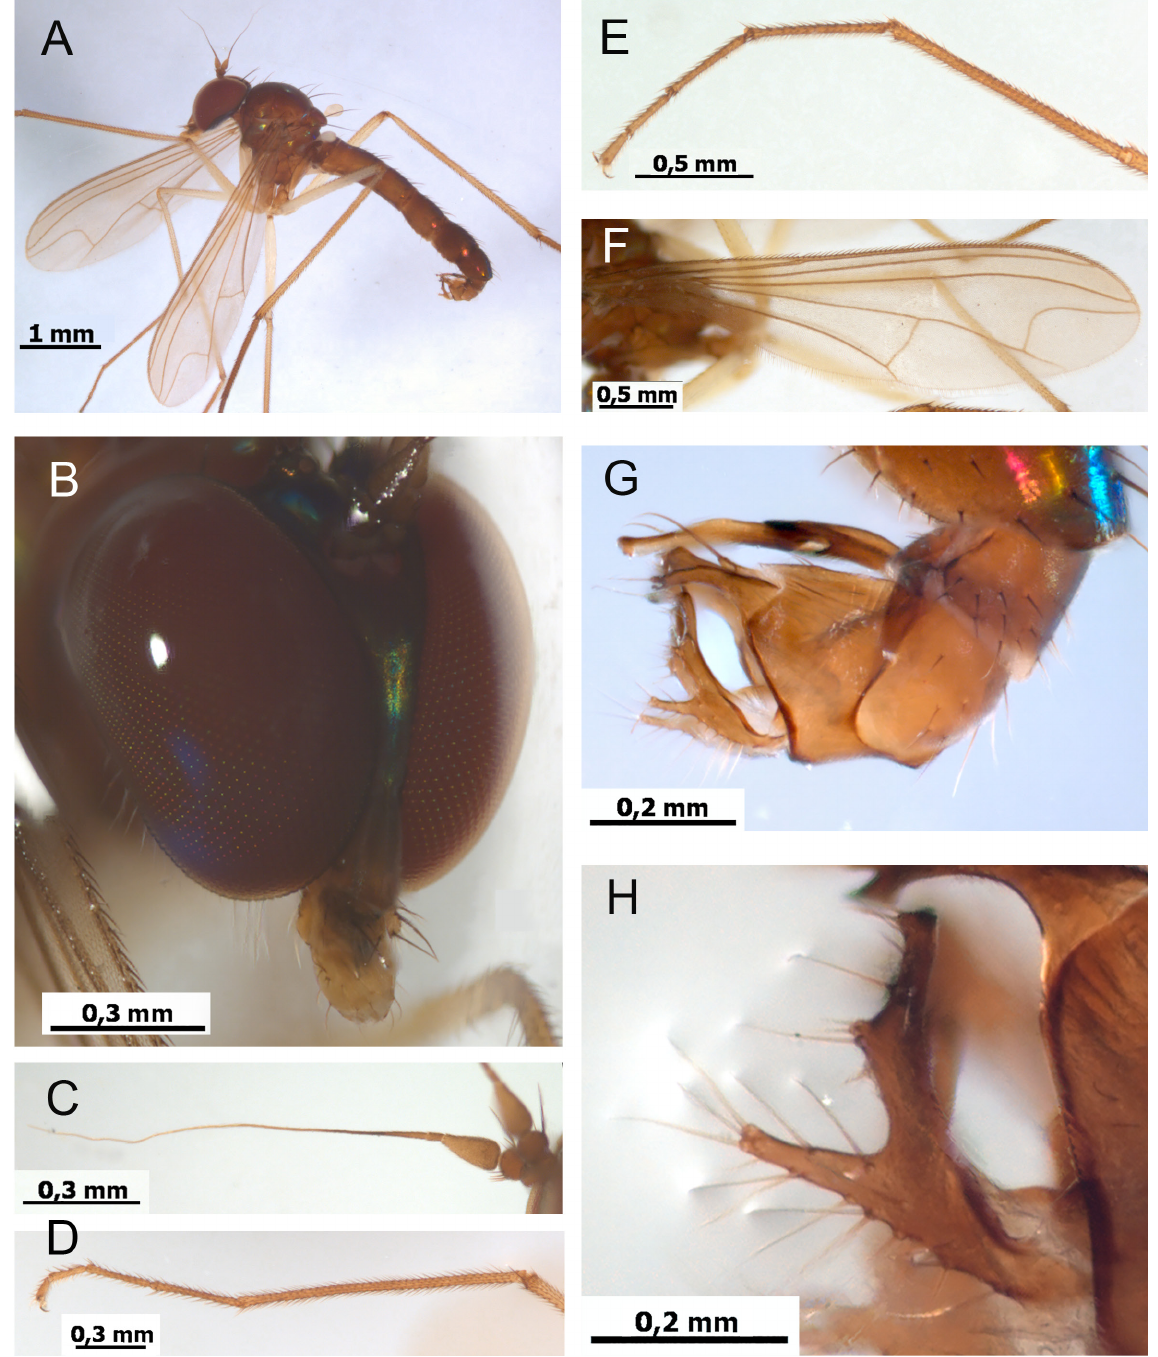
Fig. 7. Amblypsilopus udzungwensis sp. nov., holotype, ♂ (ZMUC). A . Habitus. B . Head. C . Antenna. D . Foretarsus. E . Mid tarsus. F . Wing. G . Hypopygium after maceration, left lateral view. H . Surstylus, lateral